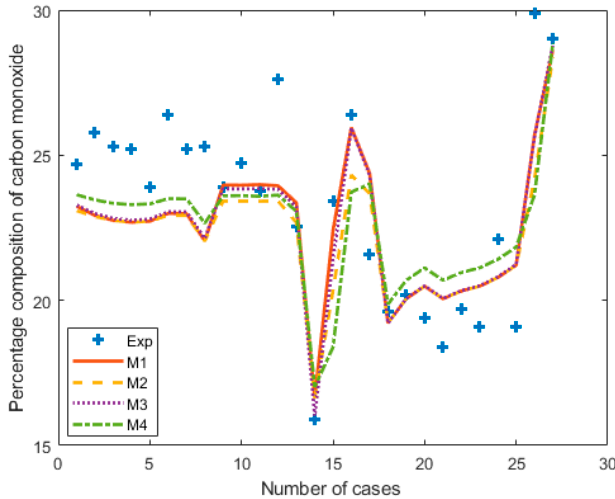
Figure 4. Comparison of the carbon monoxide composition with experiments and models.